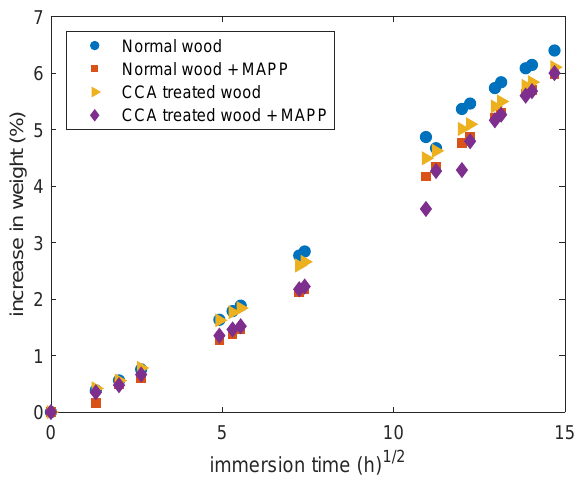
Figure 9. Increase in weight as a function of immersion time at 60 ◦